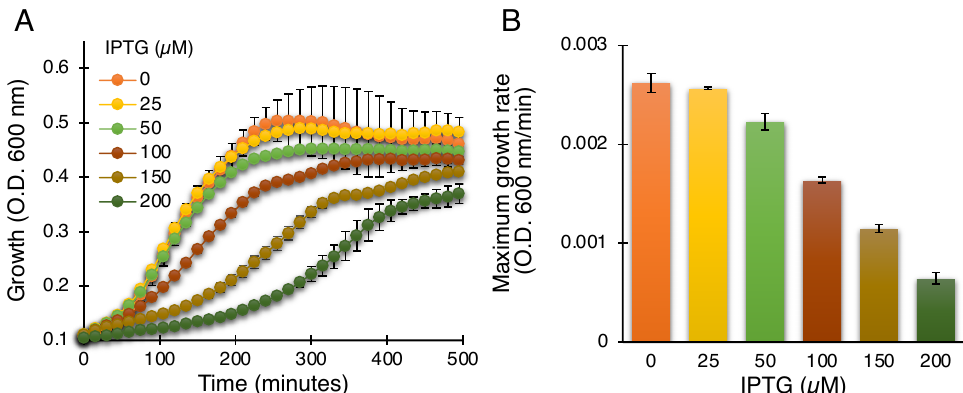
Figure 1. Standardization of ZikV-M as a viroporin in the negative genetic assay. Growth curves ( A ) and maximal growth rates ( B ) of DH10B bacteria expressing ZikV-M, grown in LB media with an increasing dose of IPTG, as